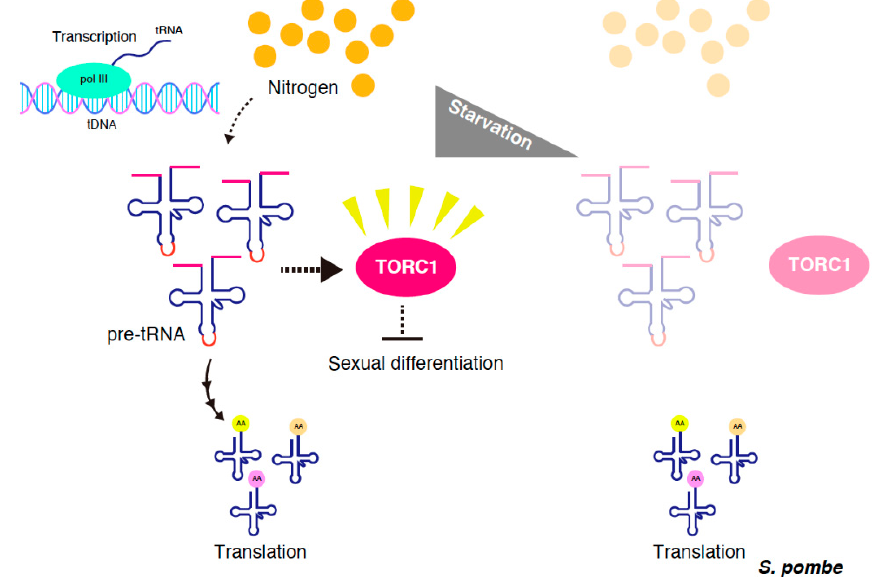
Figure 2. tRNA precursor-mediated TORC1 regulation in Schizosaccharomyces pombe . Under nitrogen-rich conditions, tRNA precursors positively regulate TORC1 activity. Under nitrogen-starved conditions, the expression of tRNA precursors decreases, resulting in the inactivation of TORC1.